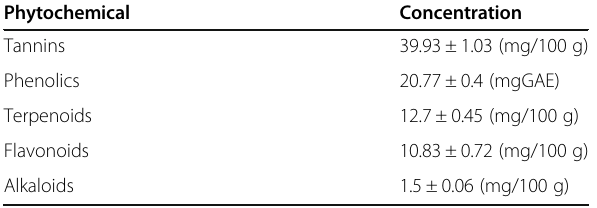
Table 1 Phytochemical constituents of EAFPB Phytochemical